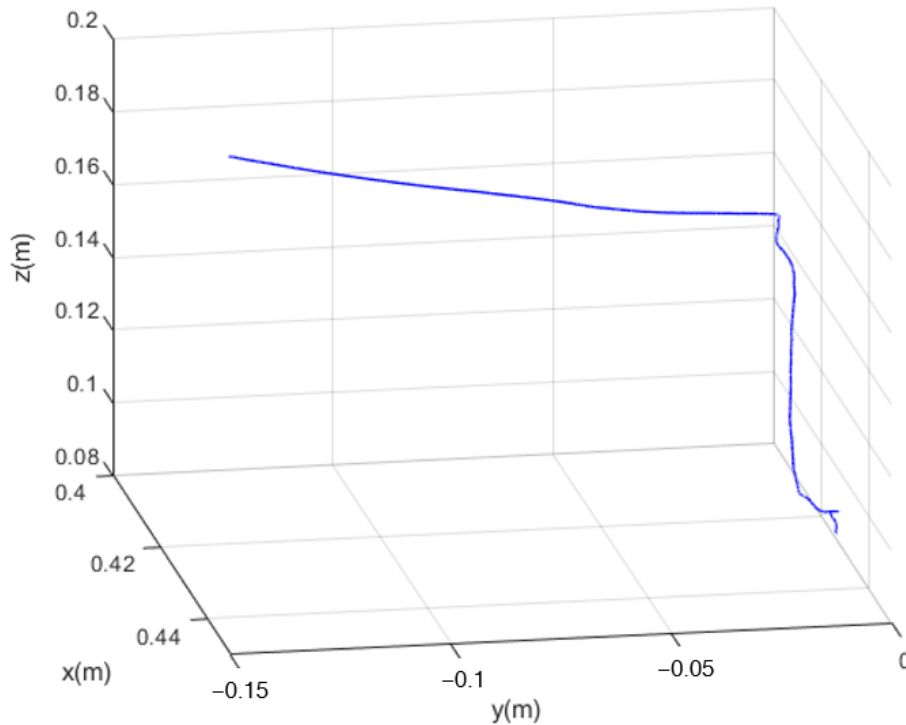
Figure 21. The manipulator end-effector trajectory.